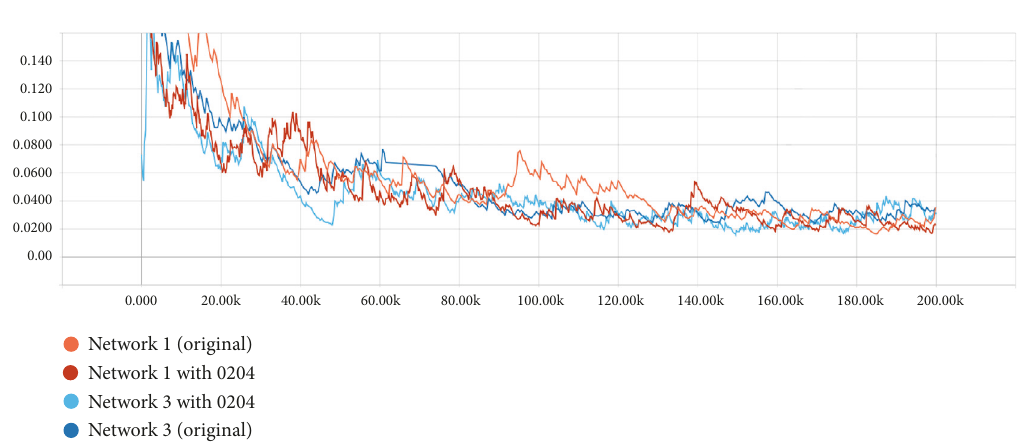
Figure 6: Sensitivity analysis of Networks 1 and 3 with data from Network 2-4.